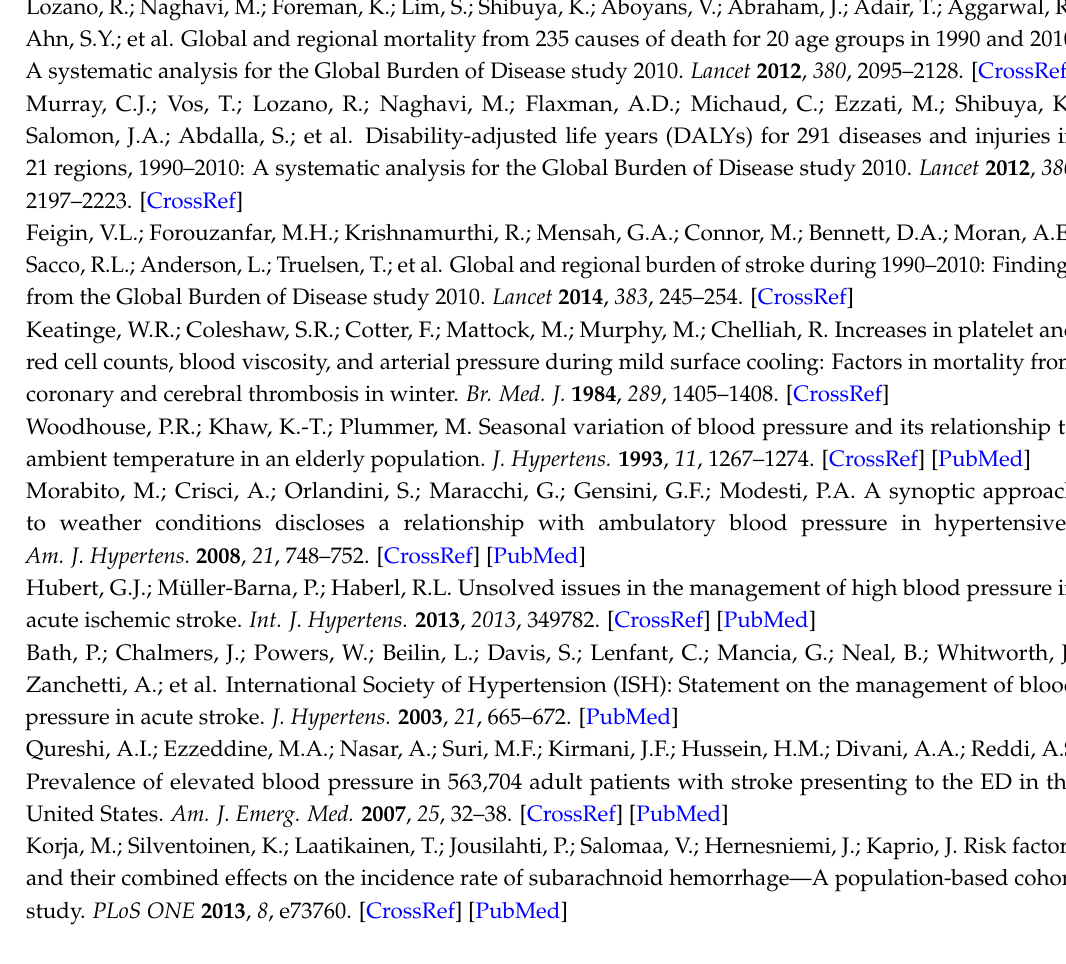
Table S1: Meta-analysis for ambient temperature and ischemic stroke (IS), Table S2: Studies included in systematic review of mean temperature and ischemic stroke (IS), Table S3: Studies included in systematic review of mean temperature and ischemic stroke (IS) by sex, Table S4: Studies included in systematic review of ambient temperature and ischemic stroke (IS) by age, Table S5: Studies included in systematic review of temperature change and ischemic stroke (IS), Table S6: Meta analysis for mean temperature and intracerebral hemorrhage (ICH), Table S7: Studies only included in systematic review of mean temperature and intracerebral hemorrhage (ICH), Table S8: Studies included in systematic review of mean temperature and intracerebral hemorrhage (ICH) by sex, Table S9: Studies included in systematic review of ambient temperature and intracerebral hemorrhage (ICH) by age, Table S10: Studies included in systematic review of temperature change and intracerebral hemorrhage (ICH), Table S11: studies for mean temperature and subarachnoid hemorrhage (SAH), Table S12: Studies included in systematic review of ambient temperature and subarachnoid hemorrhage